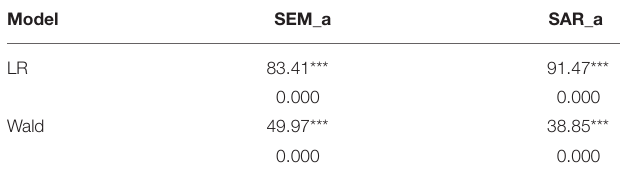
TABLE 8 | Regression results of